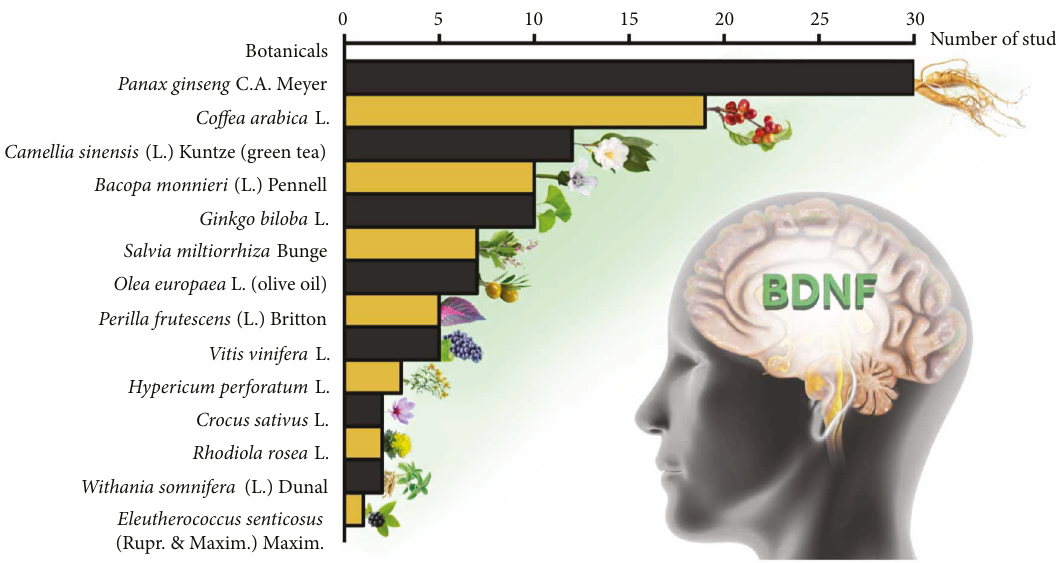
Figure 2: Number of studies investigating BDNF in the central nervous system for each botanical or active